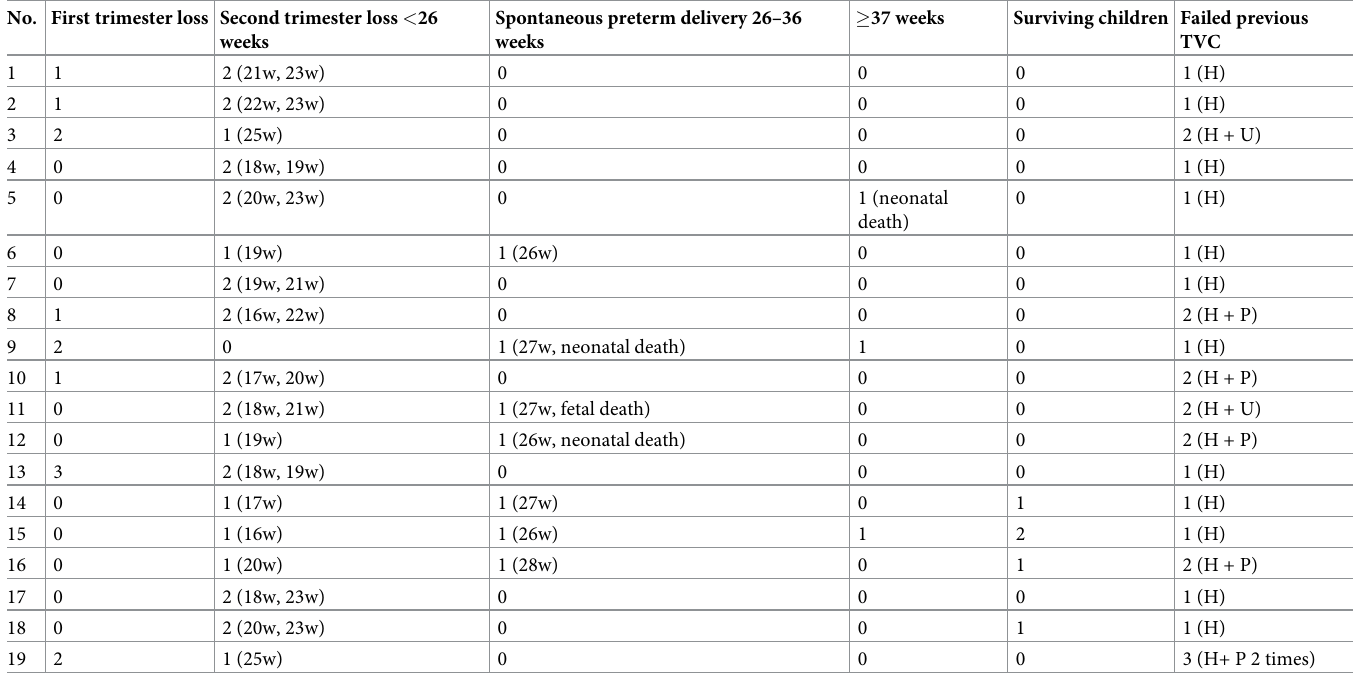
Table 2. Obstetric history of women with twin pregnancy selected for transabdominal cerclage.